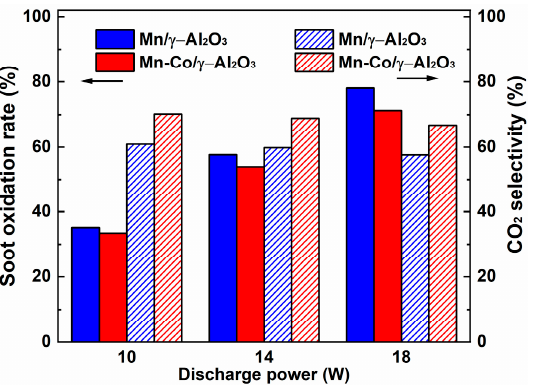
Figure 6. Effect of discharge power on plasma–catalytic soot oxidation over the Mn-Co/ γ -Al 2 O 3 and Mn/ γ -Al 2 O 3 catalysts (reaction temperature: 150 °C, reaction time: 30 min, oxygen content: 10 vol.% and gas flow rate: 500 mL·min − 1 ).